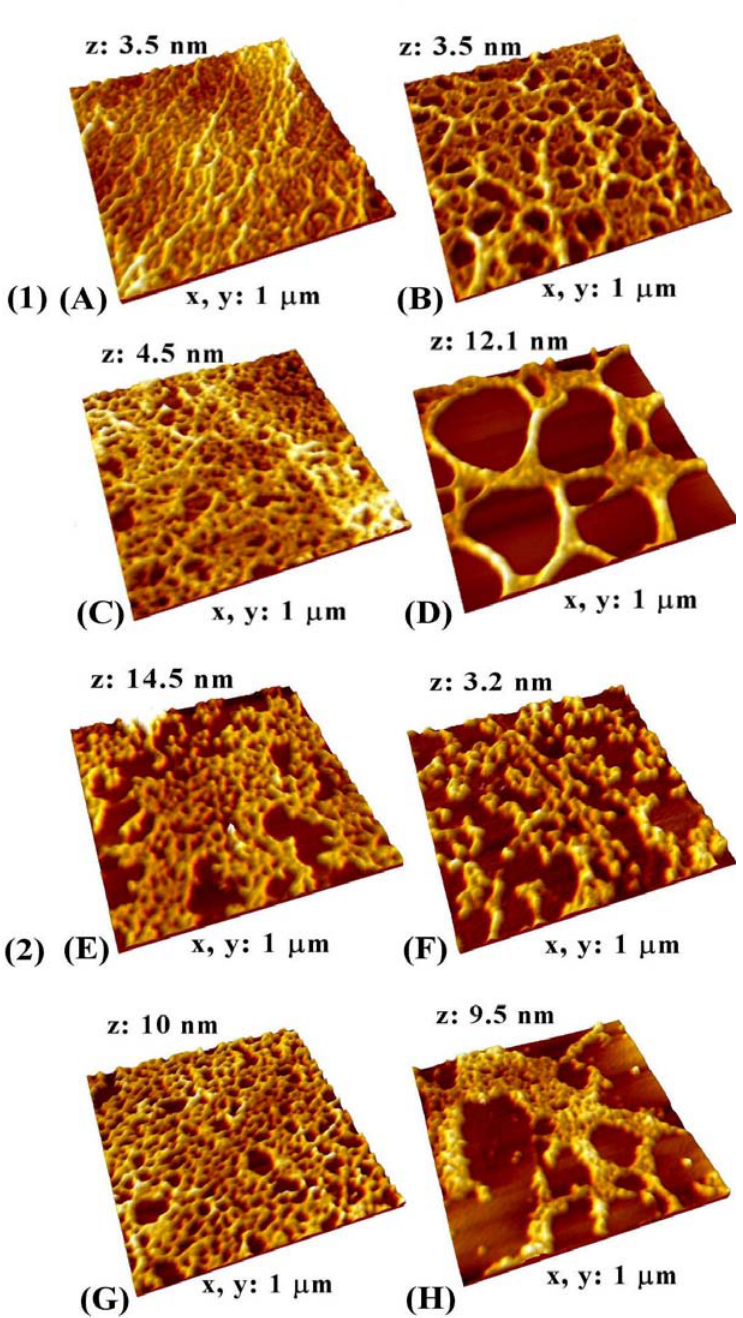
Fig. 4 MAC mode AFM topographical images in air of the DNA-biosensor surface prepared onto HOPG by 3 min adsorption in 0.1 M electrolyte solution containing: (1) 60 µ g/ml dsDNA; (A, B) free adsorption in (A) pH 5.3 acetate buffer and (B) pH 7.0 phosphate buffer; (C, D) at a deposition potential of +300 mV (vs. AgQRE) in (C) pH 5.3 acetate buffer and (D) pH 7.0 phosphate buffer; (2) 5 µ g/ml ssDNA; (E, F) free adsorption in (E) pH 5.3 acetate buffer and (F) pH 7.0 phosphate buffer; (G, H) at a deposition potential of +300 mV (vs. AgQRE) in (G) pH 5.3 acetate buffer and (H) pH 7.0 phosphate buffer [From Ref [14] with